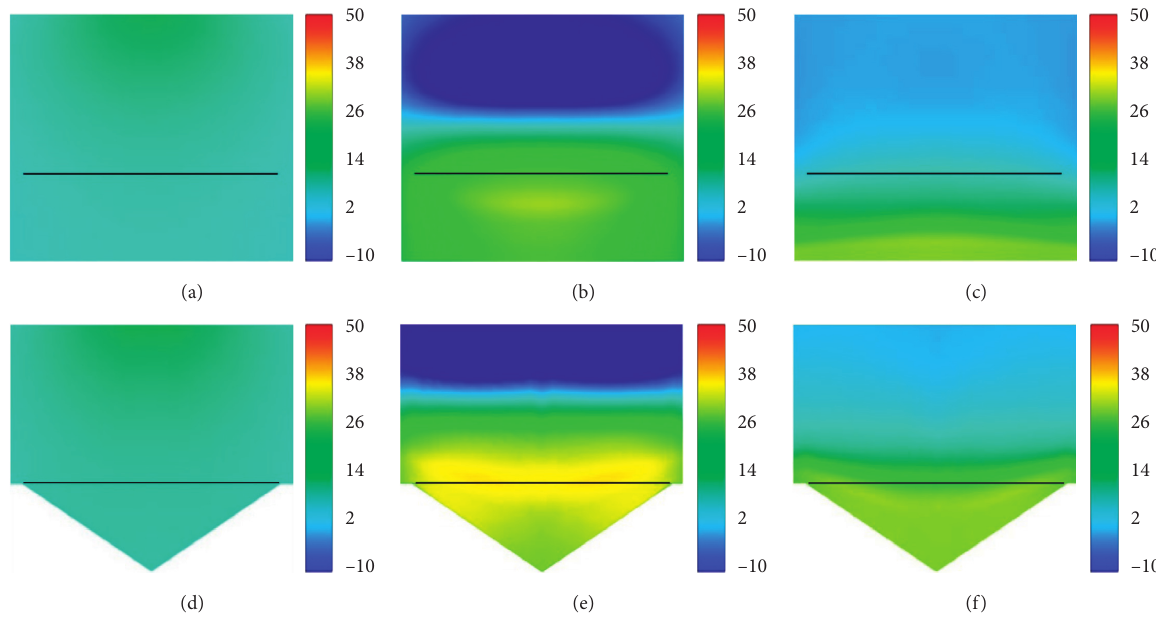
Figure 9: Contour of wind speeds in the cross section of flat and gorge terrains at the three typical time. (a) Flat terrain, t � 50s. (b) Flat terrain, t � 100s. (c) Flat terrain, t � 150s. (d) Gorge terrain, t � 50s. (e) Gorge terrain, t � 100s. (f) Gorge terrain, t �